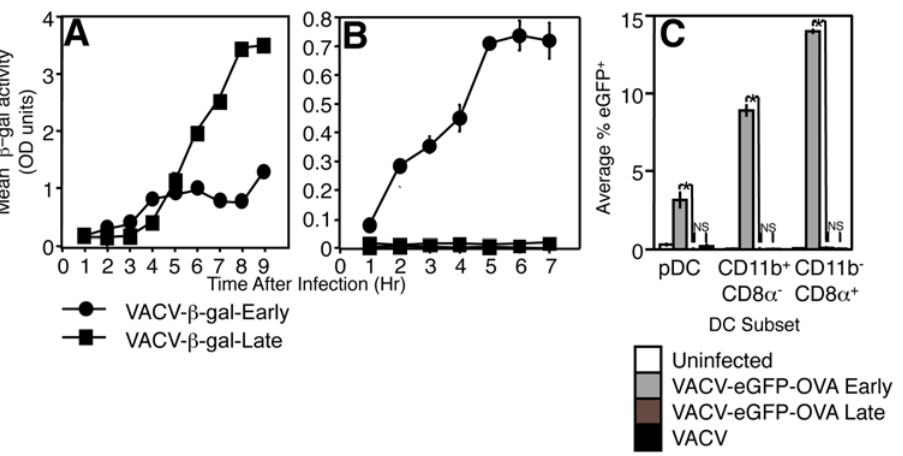
Figure 2. VACV-infected DC do not produce late antigens. Production of b -gal was measured in TAg- b 2 m neg fibroblasts (A) or BMDC (B) infected with rVACV- b -gal-Early ( $ ) or rVACV- b -gal-Late ( & ). Note the 5 h time point in (A) at which production of early and late promoter-driven b - gal is at equivalent levels. (C) Production of eGFP was measured in pDC, CD11b + CD8 a 2 DC, or CD11b 2 CD8 a + DC subsets that were uninfected (white bars) or infected with rVACV-eGFP-OVA-Early (light gray bars), rVACV-eGFP-OVA-Late (dark gray bars), or VACV-WR (black bars). *P , 0.001, NS=Not Significant (P . 0.05).